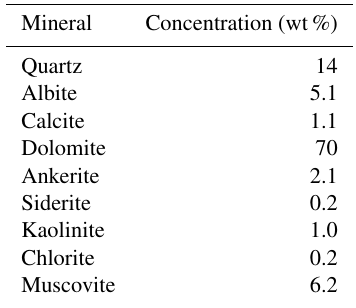
Table A3. Mineral concentration of Nuccaleena dolostone (EC26) used in the leaching experiment.